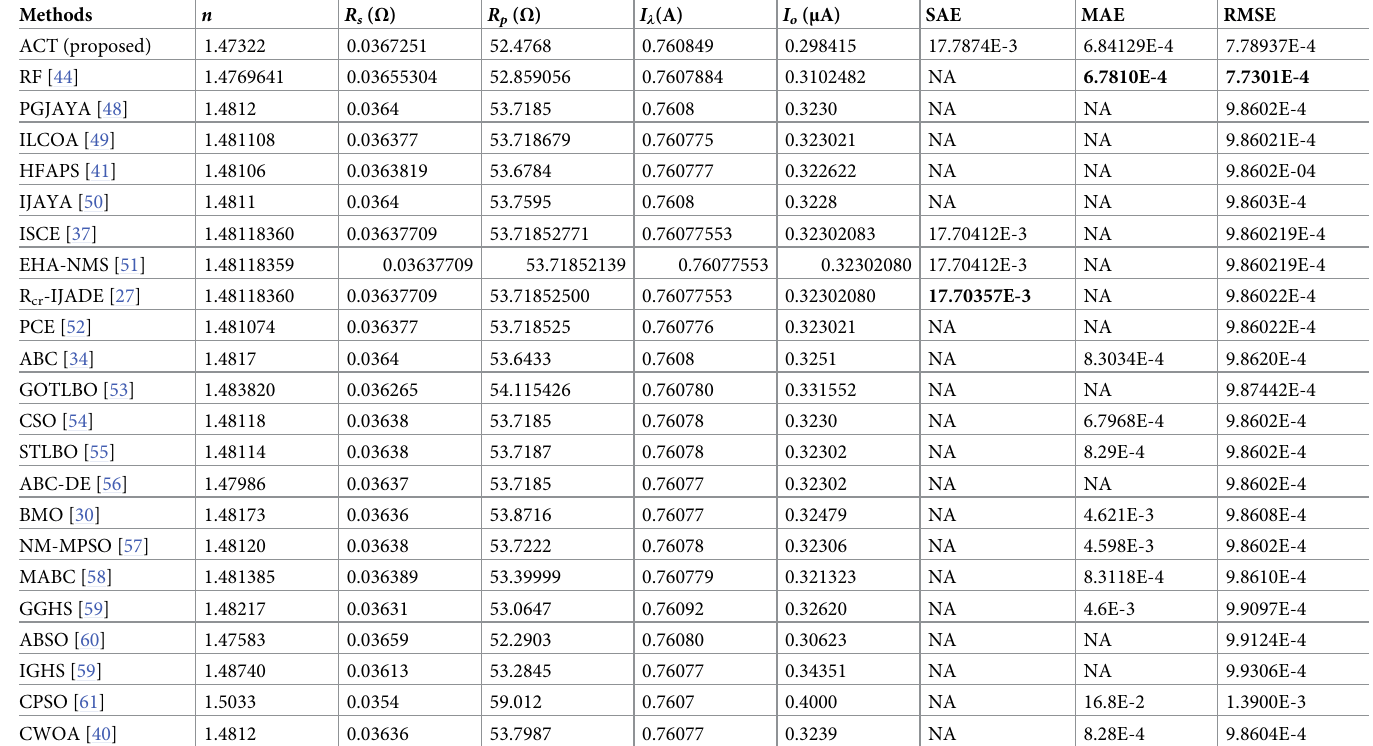
Table 2. Comparison of different parameters extraction methods for single-diode model of R.T.C. France solar cell.